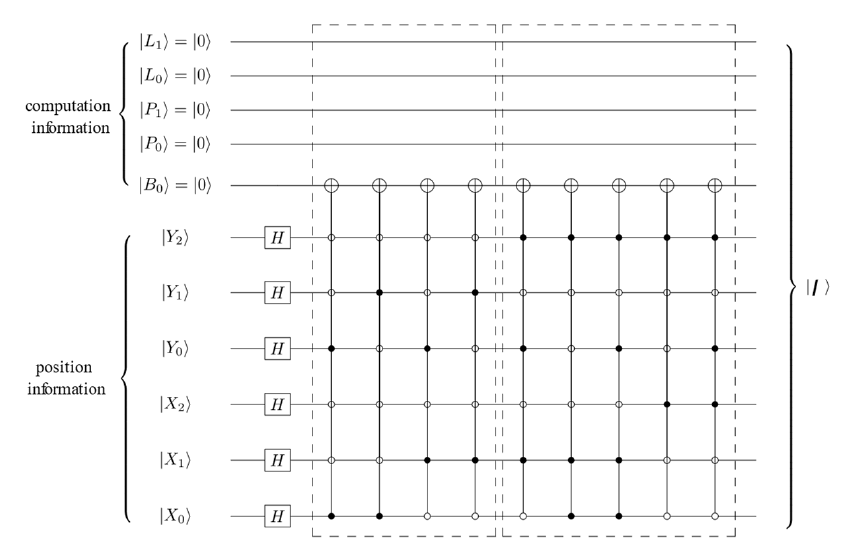
Figure 3. The quantum circuit of Figure 2b.